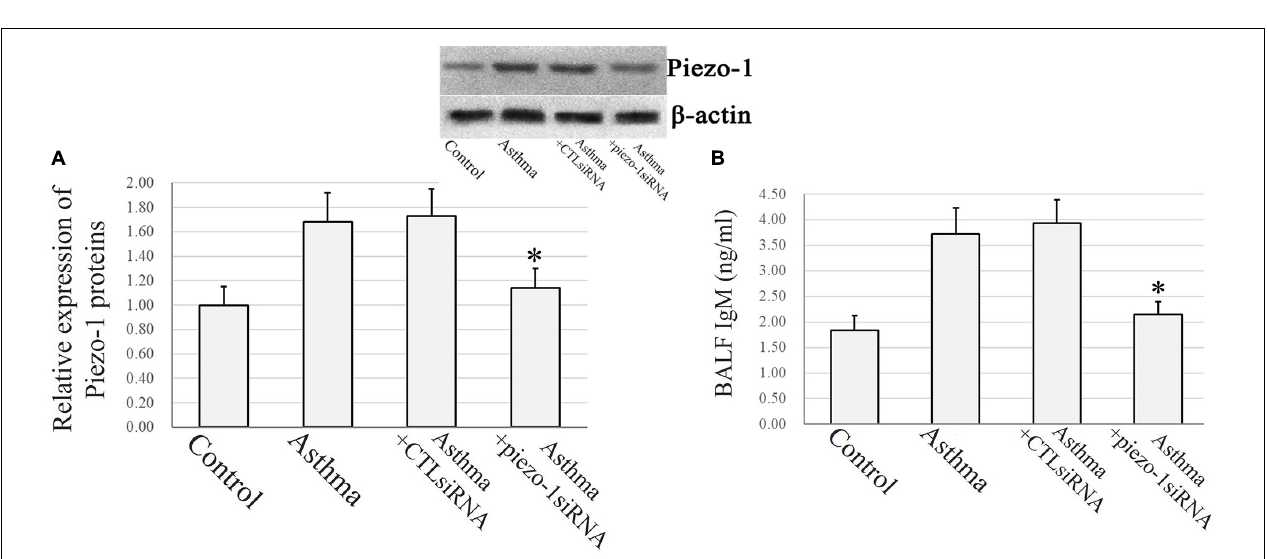
FIGURE 1 | Expression of Piezo-1 in the bronchial epithelium. Mouse lung tissues were immunostained with rabbit anti-piezo1 antibody (1:200) at room temperature in a humidified environment for 1 h and then incubated with FITC-linked goat anti-rabbit antibody (1:100, ZSGB-BIO, Beijing, China) for 30 min. Cell nuclei were visualized by staining with DAPI. The IOD/area of Piezo-1 (green fluorescence) in the bronchial epithelium was recorded under a confocal microscope. (A) A representative photo of normal mice is shown. (B) A representative photo of asthmatic mice is shown. (C) Scatter diagram of Piezo-1 protein expression in the airway epithelium (IOD/area). ∗ P < 0.05 vs. control mice.